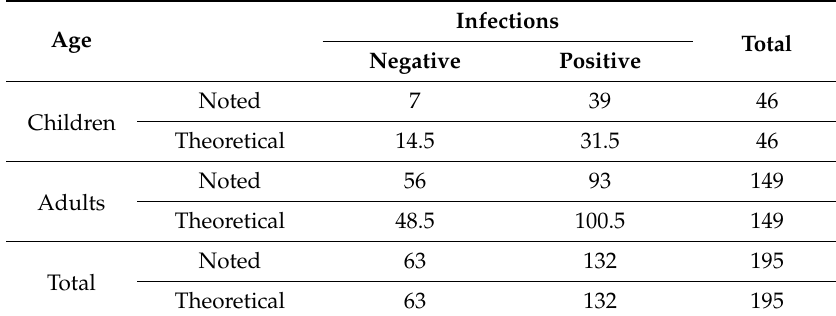
Table 7. Contingency table of correlation of age and infection.